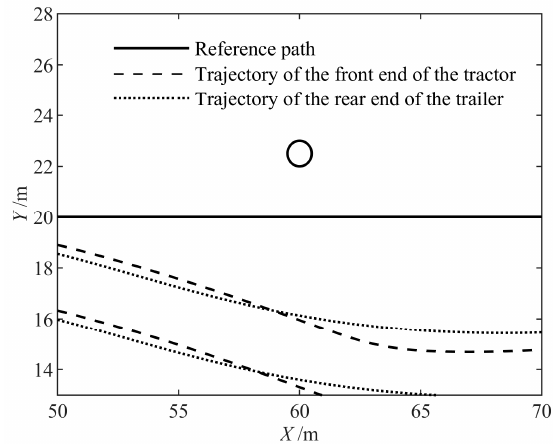
Figure 10. Partially enlarged view of Figure 9.